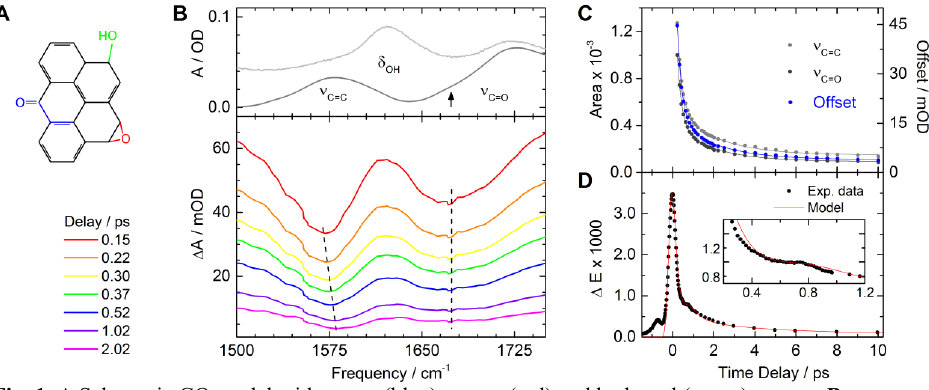
Fig. 1. A Schematic GO model with enone (blue), epoxy (red) and hydroxyl (green) groups. B Static and transient spectra of GO ( ∆ t: 0.15ps to 2ps). C Time traces of the ν C=C , ν C=O , and carrier response. D THz response of GO after 2µm